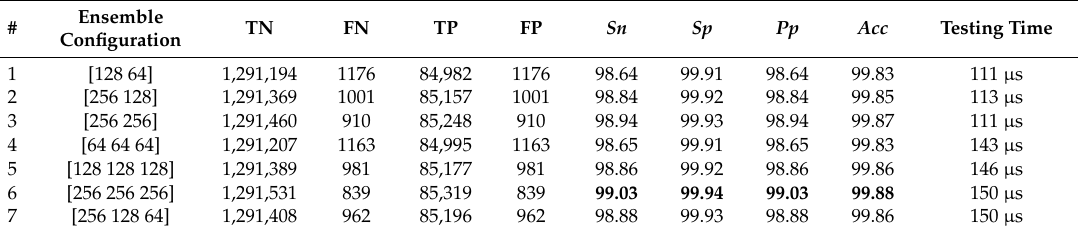
Table 5. Performance of various ensemble of depthwise separable CNN